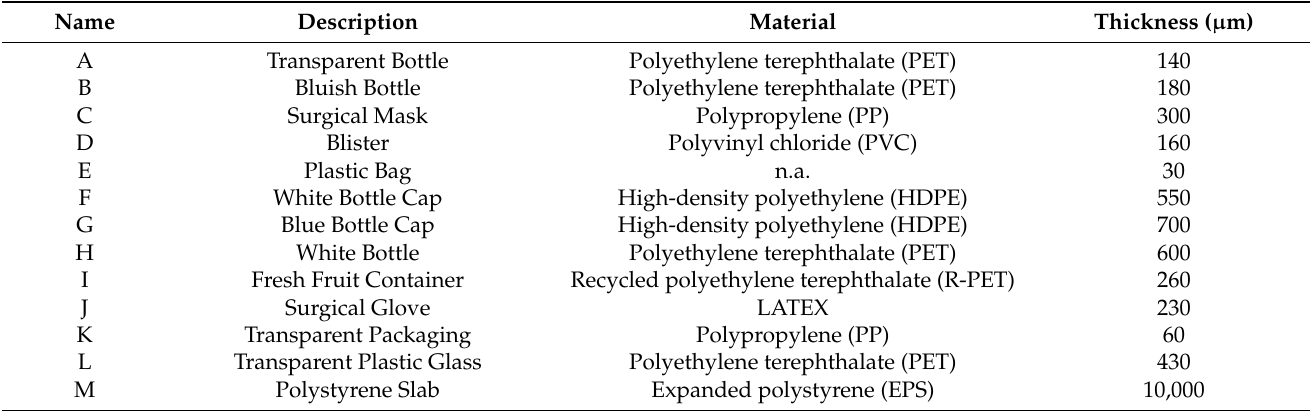
Table 1. List of commercial plastic